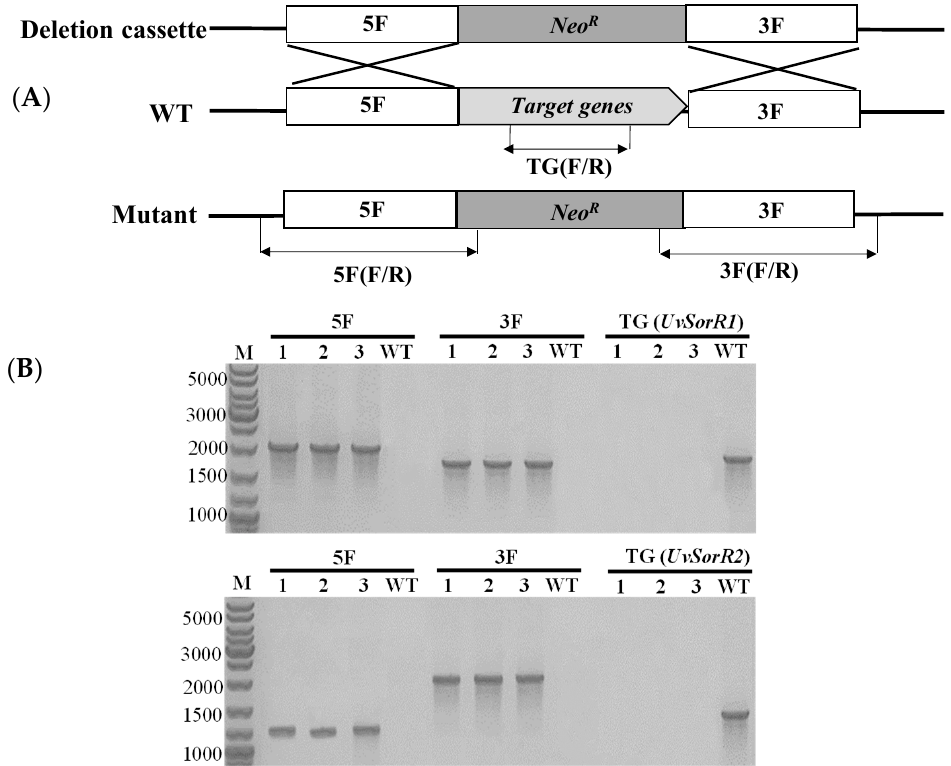
Figure 6. Generation of ∆ UvSorR1 and ∆ UvSorR2 deletion mutants in U. virens . ( A ) Schematic illustration of the disruption of the target gene ( UvSorR1 or UvSorR2 ). ( B ) In the ∆ UvSorR1 mutant, the upstream and downstream bands (2093 bp and 1719 bp) were only detected in the mutants (T1– T3), and the UvSorR1 band (1882 bp) was only detected in the WT strain; in the ∆ UvSorR2 mutant, the upstream and downstream bands (1261 bp and 2042 bp) were only detected in the mutants (T1–T3), and the UvSorR2 band (1616 bp) was only detected in the WT strain. Lane M: 1000 bp DNA